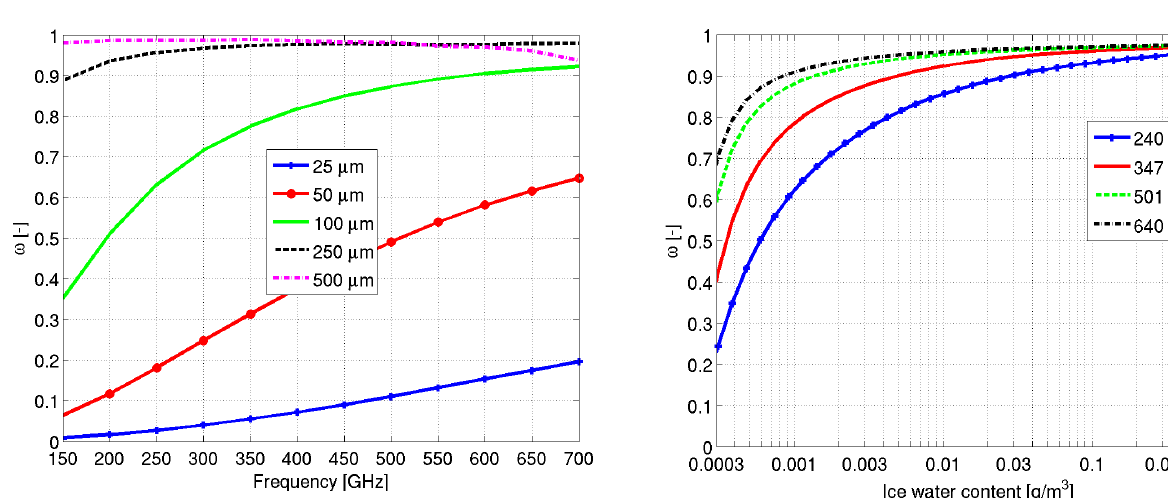
Fig. 2. Single scattering albedo ( ω ) for five different diameters of spherical ice particles.